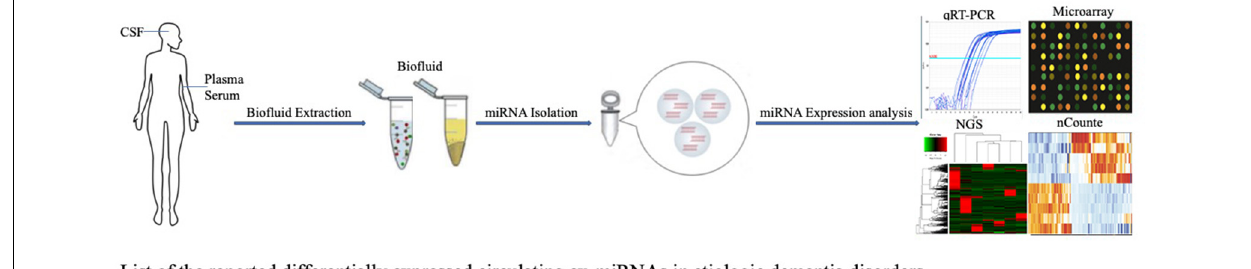
sensitivity and specificity (81.5% and 70.1%, respectively).